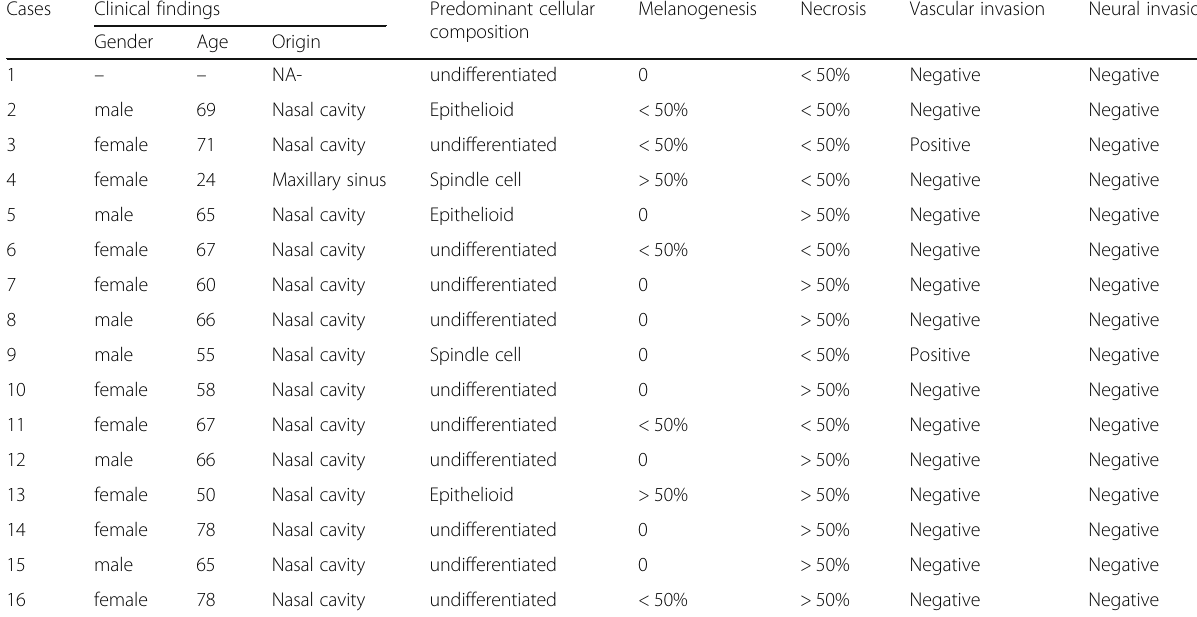
Table 2 Clinicopathological findings of 16 cases of sinonasal melanoma Cases Clinical